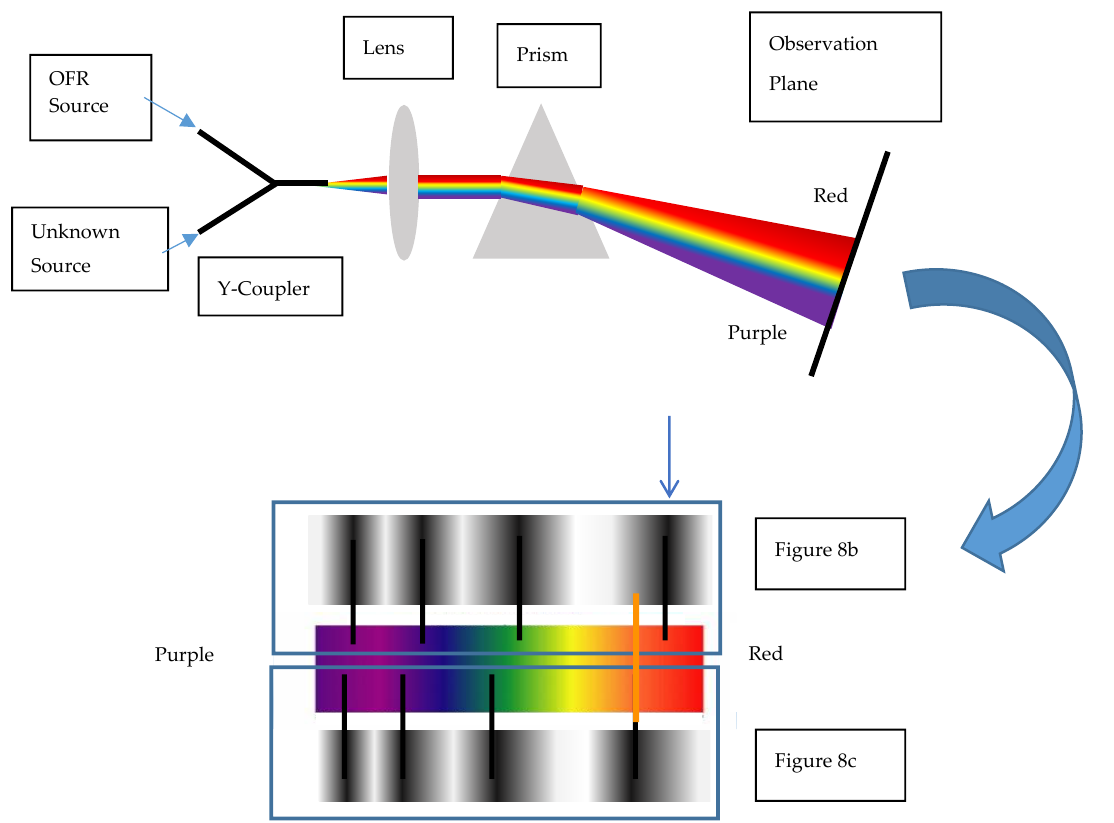
Figure 9. Scheme for determining an unknown wavelength using OFR.